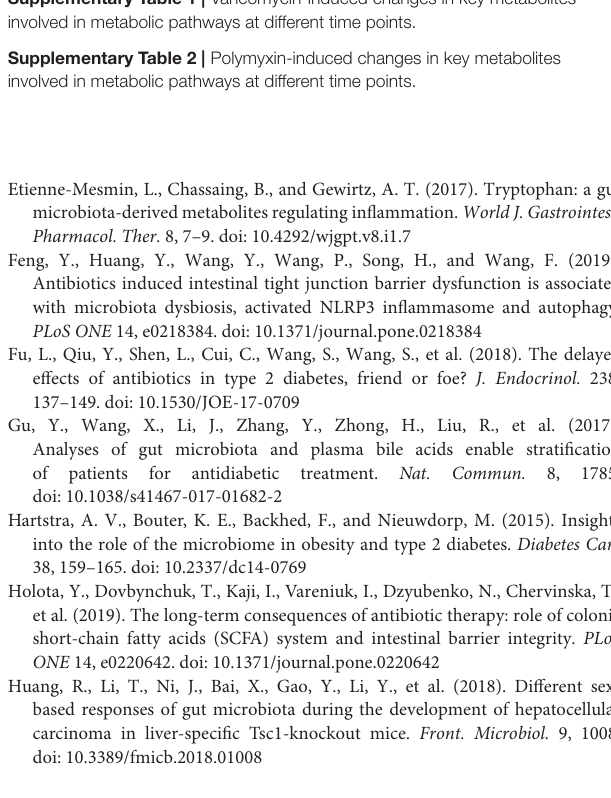
Supplementary Figure 1 | The histopathology results of colon tissues treated by antibiotics for 8 and 28 weeks (HE stain, X 200). VAN, vancomycin; PMB, polymyxin B; CON, control. Supplementary Figure 2 | The histogram of the linear discriminant analysis (LDA) scores for differentially abundant taxa with baseline and VAN treated (A) and PMB treated (B) . Only taxa achieving an LDA significant threshold ≥ 4 are shown. VAN, vancomycin; PMB, polymyxin B. Supplementary Figure 3 | Vancomycin-induced changes in key metabolites, including primary bile acids (A) , secondary bile acids (B) , short-chain fatty acids (C) , long-chain fatty acids (D) , amino acids (E) , lysophosphatidylcholine (F) , and phosphatidylcholine (G) . Supplementary Figure 4 | Polymyxin B-induced changes in key metabolites, including primary bile acids (A) , short-chain fatty acids (B) , long-chain fatty acids (C) , lysophosphatidylcholine (D) , and phosphatidylcholine (E)